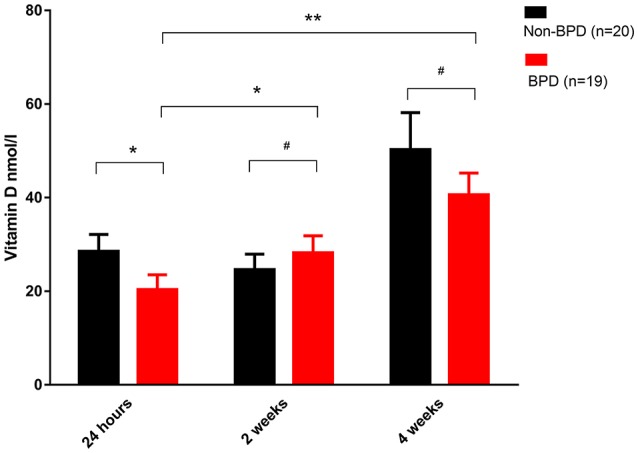
Vitamin D deficiency in the BPD patients. Venous blood samples were taken at the indicated time and plasma vitamin D was quantified. Vitamin D was significantly decreased in the 24-h samples from the BPD patients (p = 0.0134). In the 2 or 4 weeks samples, however, vitamin D was comparable in both groups. Compared with the 24-h samples, vitamin D in the BPD patients was significantly recovered after 2 weeks (p = 0.0423) or 4 weeks of therapy (p = 0.0007). Twenty non-BPD patients and 19 BPD patients were included in the final study. #p > 0.05; *p < 0.05; **p < 0.01.